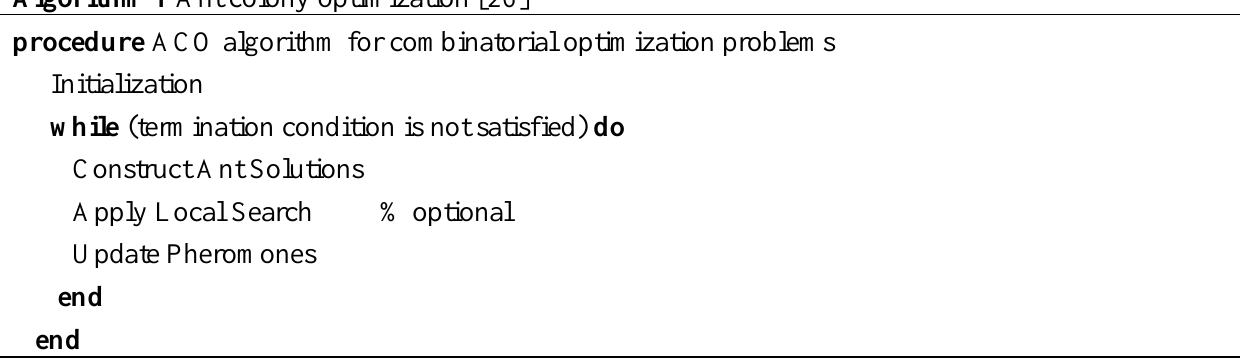
Algorithm 1 Ant colony optimization [26] procedure ACO algorithm for combinatorial optimization